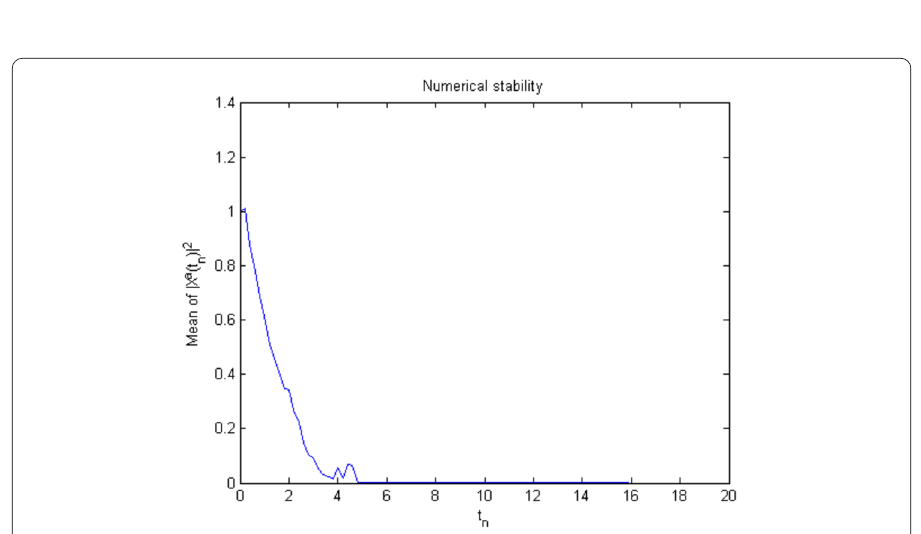
Figure 6 The average of numerical solution over 10,000 discretized Brownian paths with h = 0.2 and T = 20 for Example